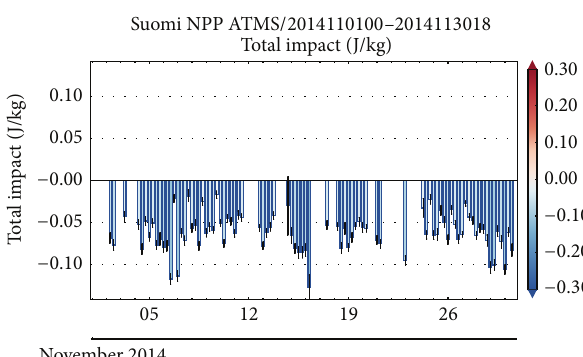
Figure 12: Time series of the FSO statistics for ATMS in the Met Office operational system for November 2014.